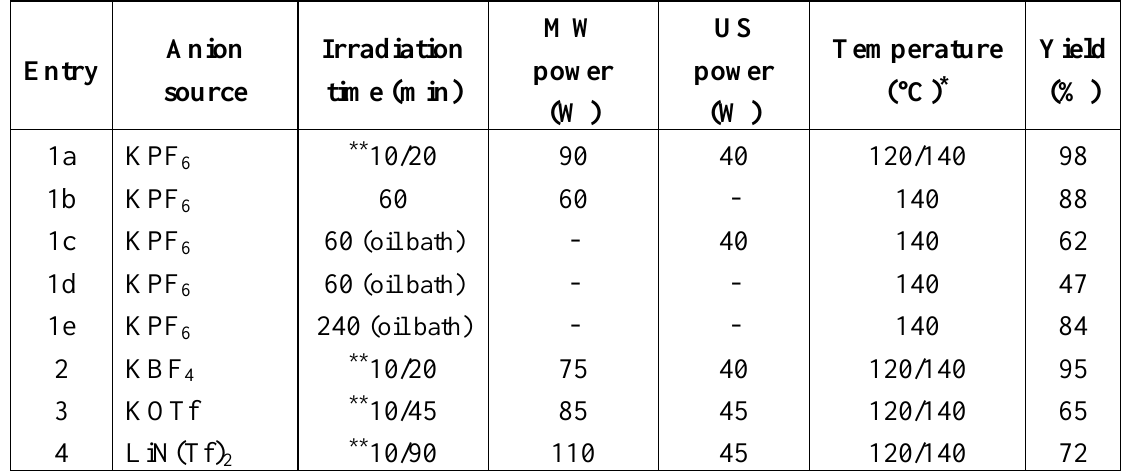
Table 1. ILs synthesis under simultaneous MW/US irradiation in a cooled reactor or under conventional heating in an oil bath. Reagents: 1-methylimidazole (1-mim) and